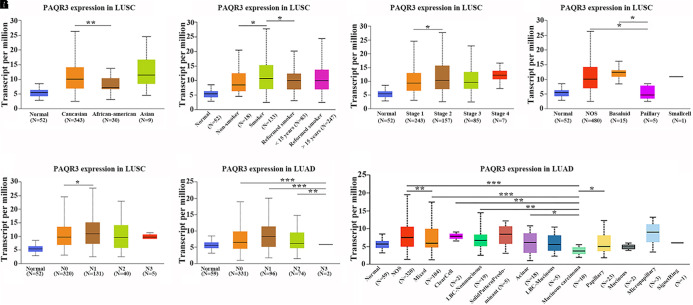
Abnormal expression of PAQR3 mRNA according to the clinicopathological features of NSCLC patients in the Ualcan database. (A–E) The clinicopathological features of LUSC patients were race, smoking, clinical stage, histological subtype, and lymph node metastasis, respectively. (F,G) Lymph node metastasis and histological subtypes of LUAD patients. NSCLC, non-small cell lung cancer; LUAD, lung adenocarcinoma; LUSC, lung squamous carcinoma; *P < 0.05; **P < 0.01; ***P < 0.001.